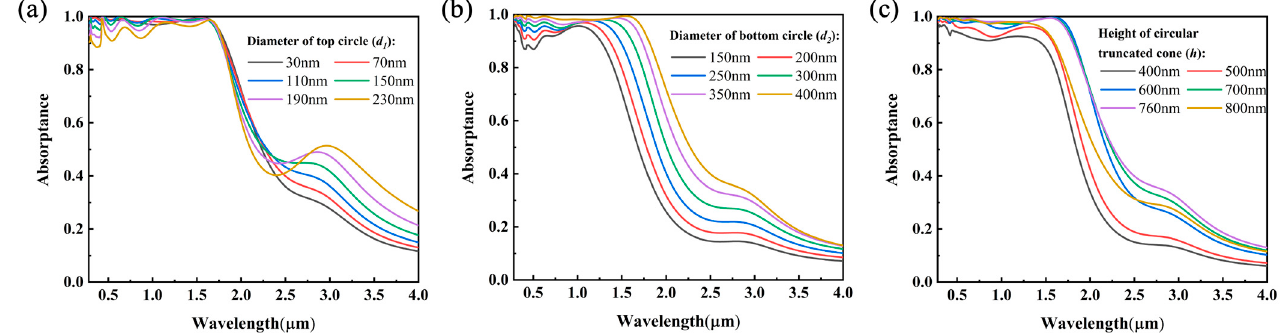
Figure 5. Energy dissipation within W truncated cone. ( a ) The contributions of the diameter ( d 1 ) of the top circle. ( b ) The contributions of the diameter ( d 2 ) of the bottom circle. ( c ) The contributions of the height ( h ) of W truncated cone.